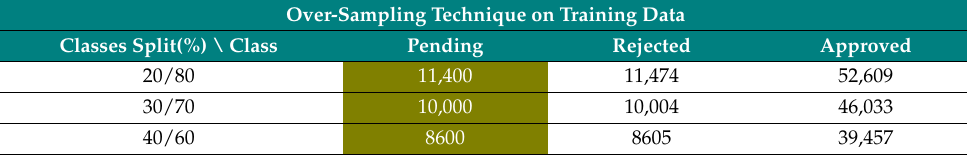
Table 3. Classes distribution after applying over-sampling on the minority class.